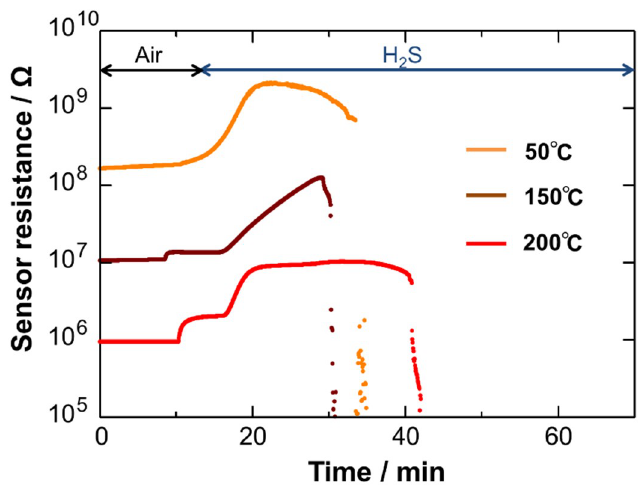
Figure 8. Response transients to 5 ppm H 2 S of the Cu 2 O NC sensor at different temperatures.